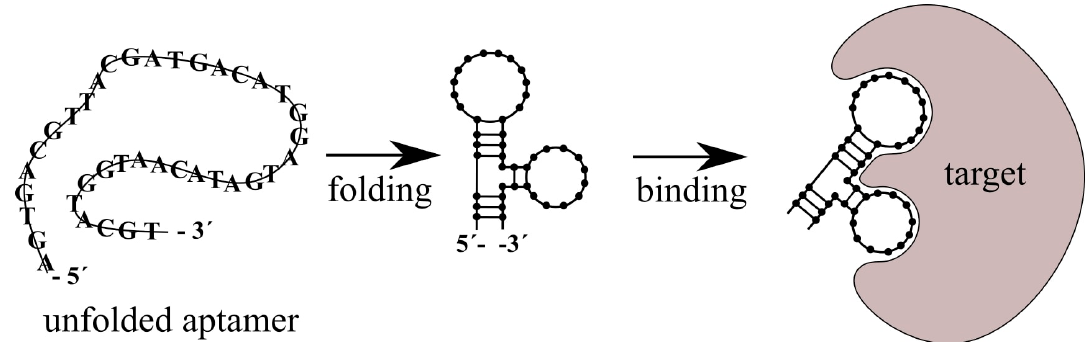
Figure 7. Scheme of transformation of aptamer in contact with target molecule. Aptamer forms 3D conformation (folding) and bind to the target.